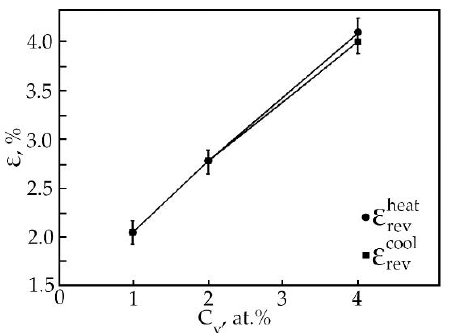
Figure 13. Concentration dependences of reversible deformation (●— during heating, ■ — during cooling) of alloys doped with V.